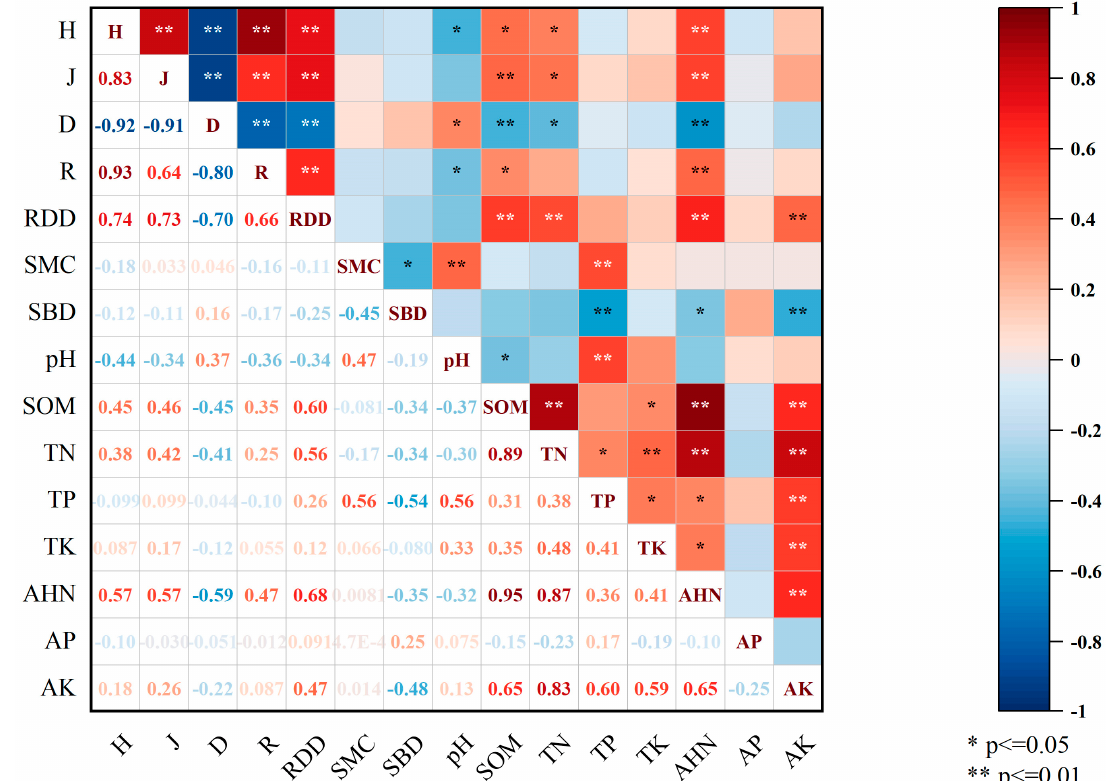
Figure 2. The correlations between the plant diversity index and soil physicochemical properties in the study plots with different rocky desertification degrees. Note: Shannon–Wiener index (H), Pielou’s index (J), Berger–Parker index (D), species richness (R), Rocky desertification degree (RDD), Soil moisture content (SMC), Soil bulk density (SBD), Soil organic matter (SOM), Total nitrogen (TN), Total phosphorus (TP), Total kalium (TK), Alka-line hydrolysis nitrogen (AHN), Available phosphorus (AP), Available kalium (AK). *, p ≤ 0.05; **, p ≤ 0.01. The same below.